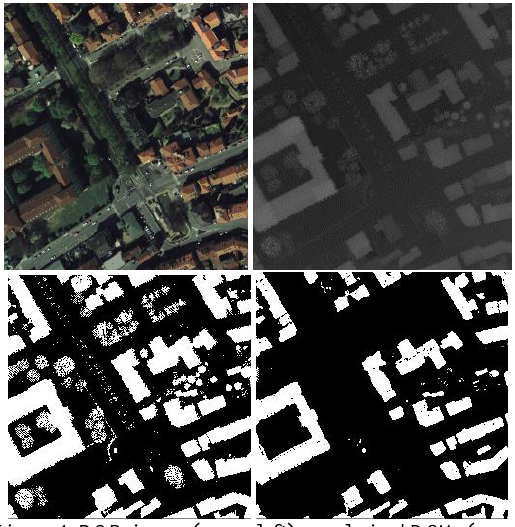
Figure 4. RGB image (upper left), regularized DSM (upper right), off-ground area (bottom left) and building (bottom right). - Geometric edge extraction on range data . The geometric breaklines are extracted from the regularized range data (depth image) considering the gradients and the local curvature between adjacent pixels. This process is repeated both for each point of the depth image and the final result is a map of the geometric breaklines from the range data (Figure 5).